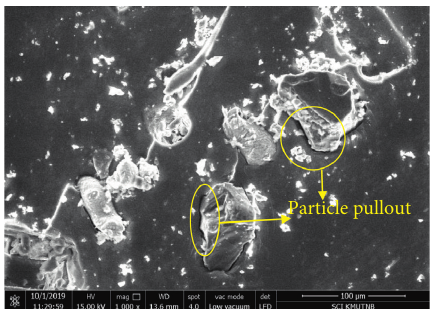
Figure 5: SEM image depicting the particle pullout from the matrix.